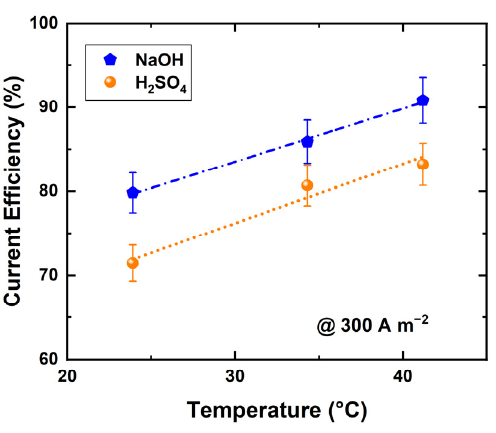
Figure 5. Current efficiency of BPED products in a stack of 10 RUs at different temperaTable 300. A m − 2 (products concentrations were 0.5 ± 0.02 N).